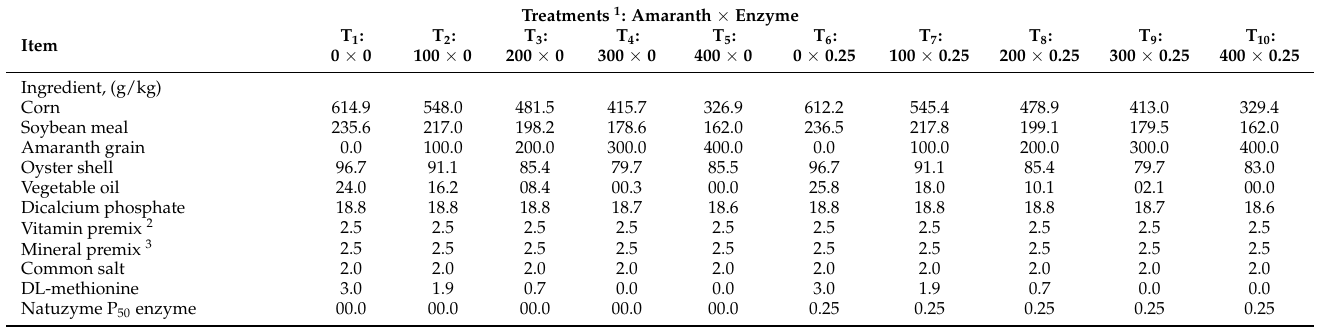
Table 1. Ingredients and chemical composition of experimental diets fed to laying